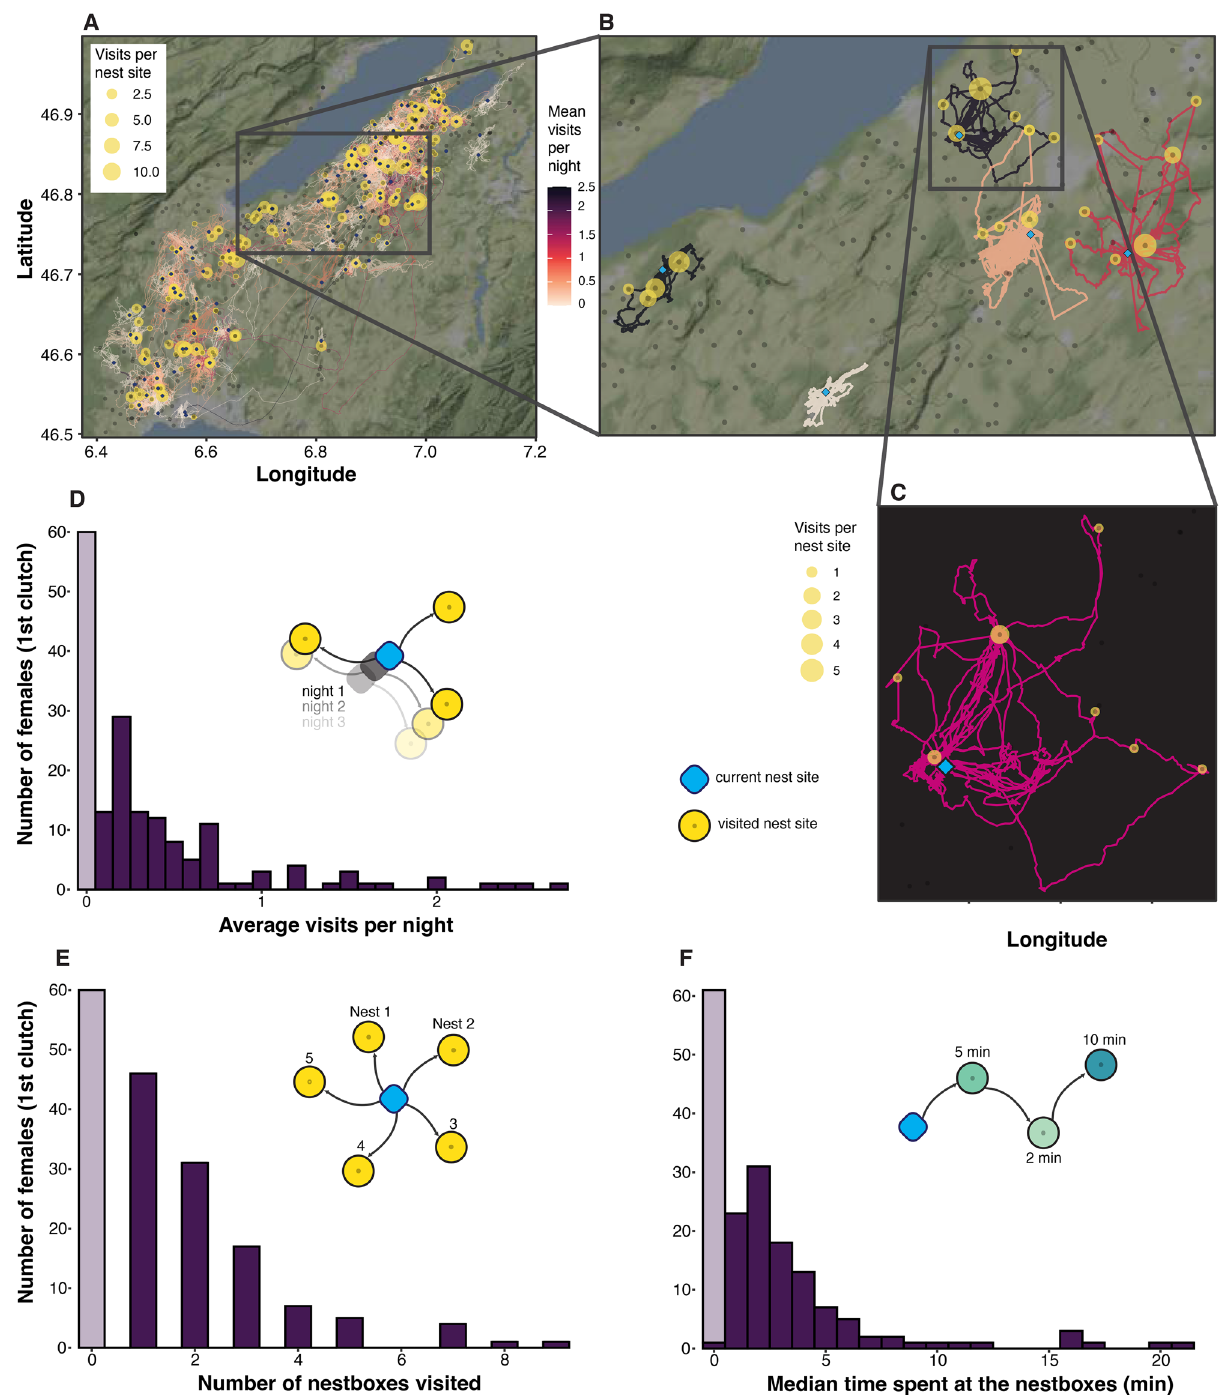
Figure 1. Schematic description and visualization of prospecting behaviour expressed by female barn owls. ( A ) Map of the study area with all tracked females considered for analysis (n = 171), highlighting average revisits per night (colour of the trajectories) and the number of visits per nest boxes (yellow circles). ( B ) Example of five female tracks with different degrees of prospecting behaviour or none (the lightest coloured track). ( C ) One track in detail, the colour of this track is for visualization purposes. ( D–F ) Histograms of the different parameters chosen to analyse the prospecting behaviour: in transparent violet females that did not visit any nest site except their own (n = 60), in dark violet the variation of the different prospecting parameters expressed by the females that visit at least one nest (n =